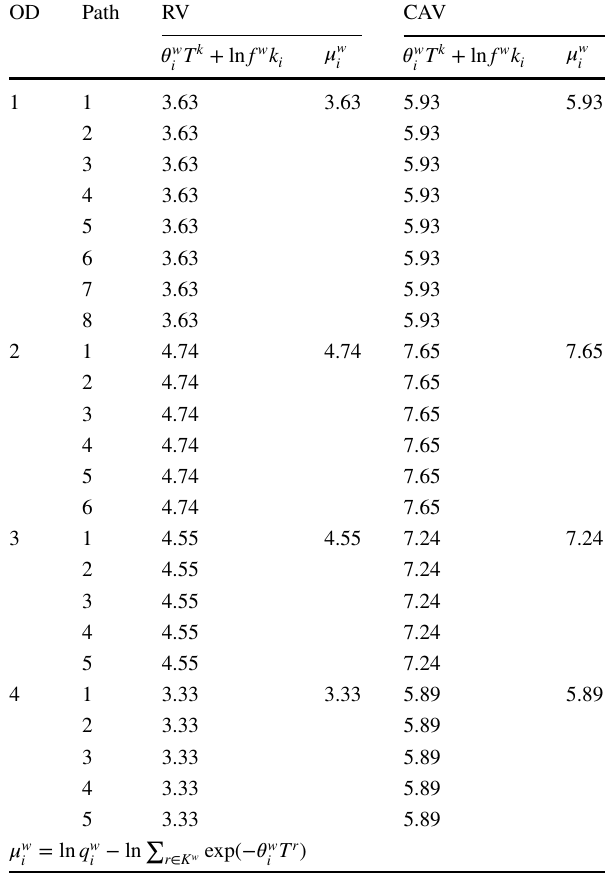
Table 3 Validation of the path choice equilibrium OD Path